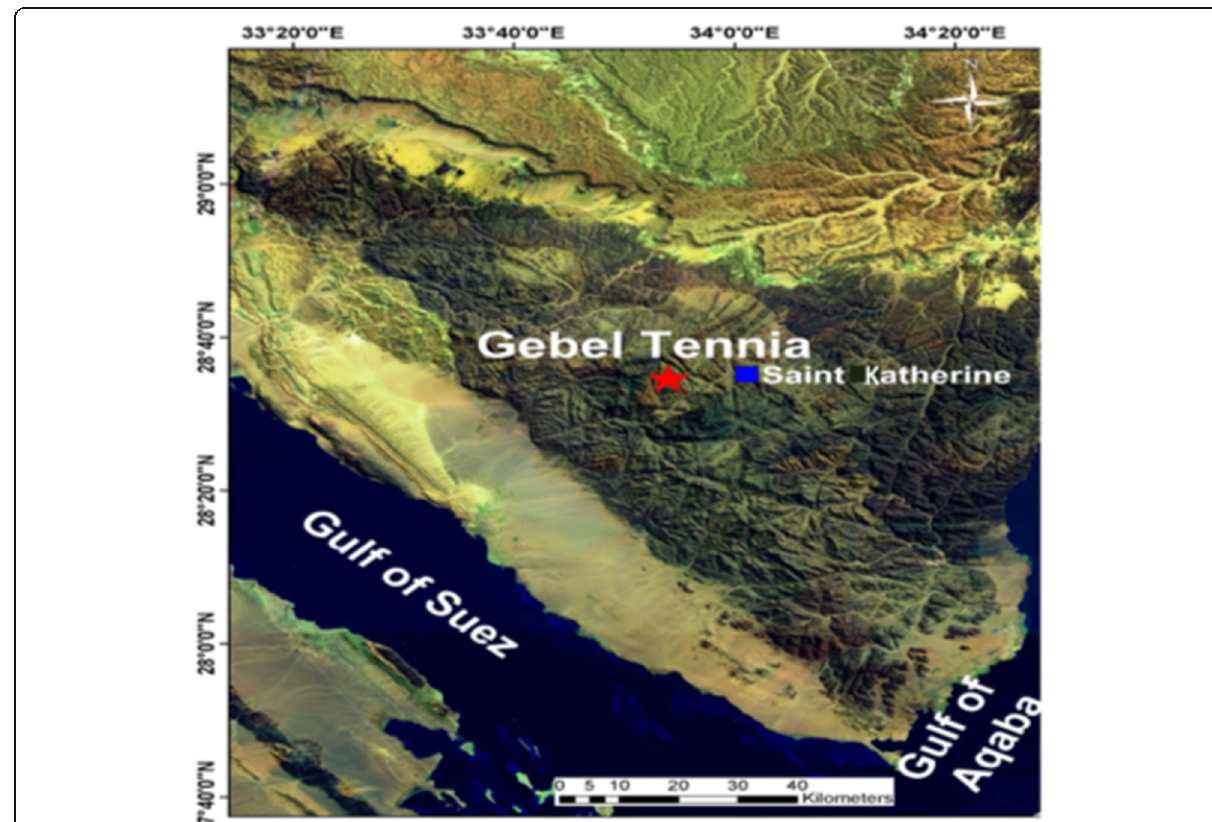
Fig. 1 A map showing the location of Gebel Tennia, the collection site of Silene